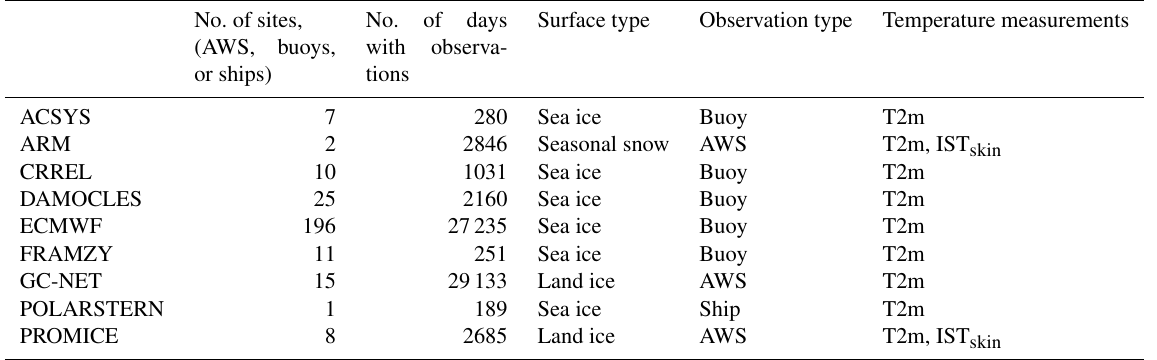
Table 1. Overview of in situ observations used in this study, covering the period 2000–2009. Surface type Observation type No. of days No. of sites, with observa- (AWS, buoys, tions or ships) ACSYS 7 280 Sea ice